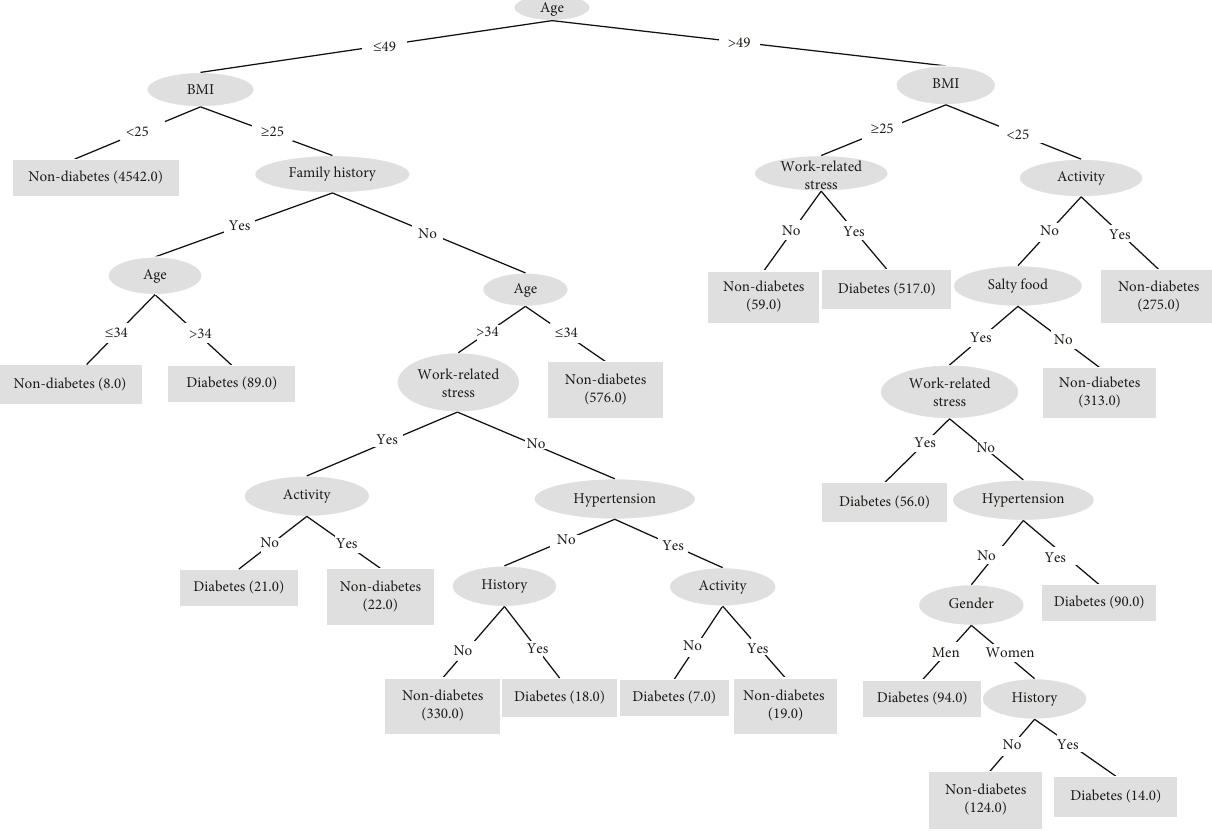
Figure 1: Decision tree approach with the training dataset in the model. The number in the bracket of each node represents the sample